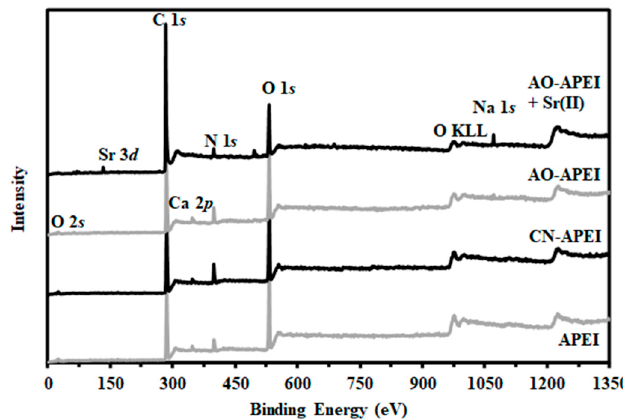
Figure 1. XPS spectra of APEI and derivatives (CN-APEI, AO-APEI) and AO-APEI after Sr(II) sorption (survey spectra).